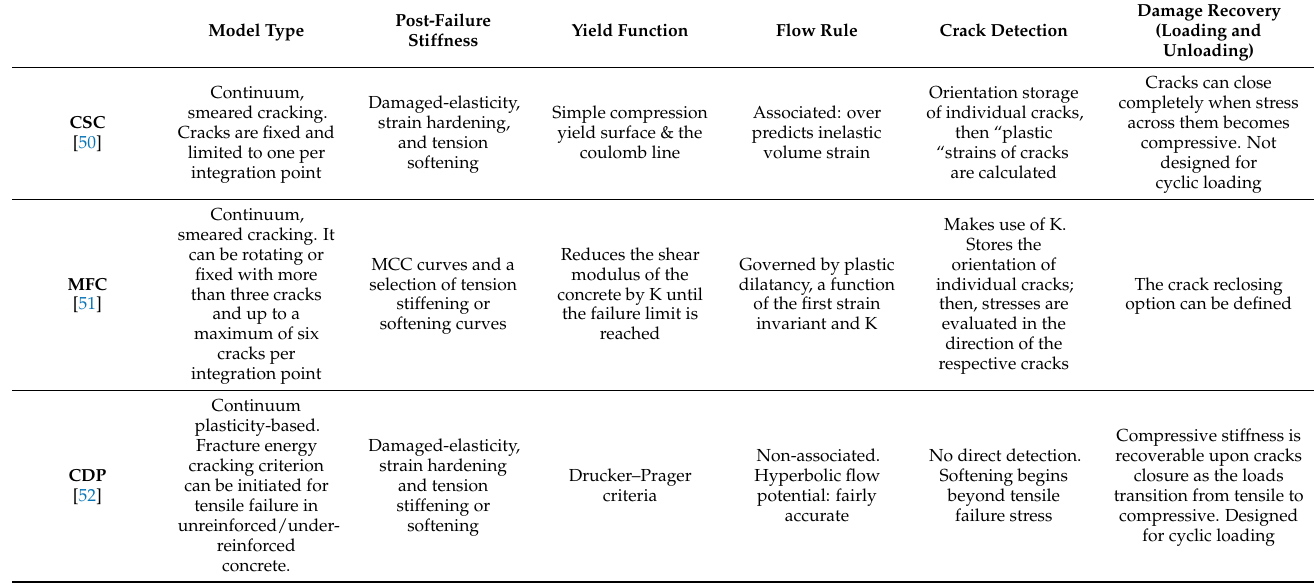
Table 4. Comparison of the Abaqus CSC, CDP, and the Diana FEA MFC